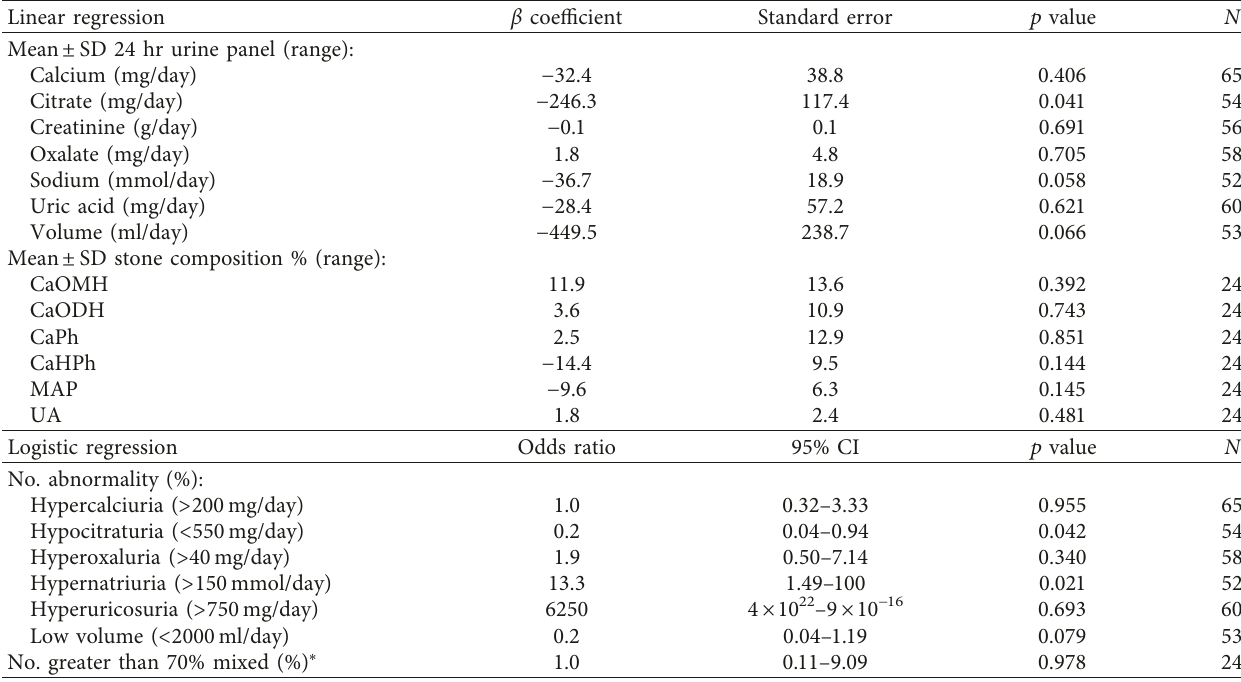
Table 3: Multivariate analysis using categorical testosterone levels within the PCOS